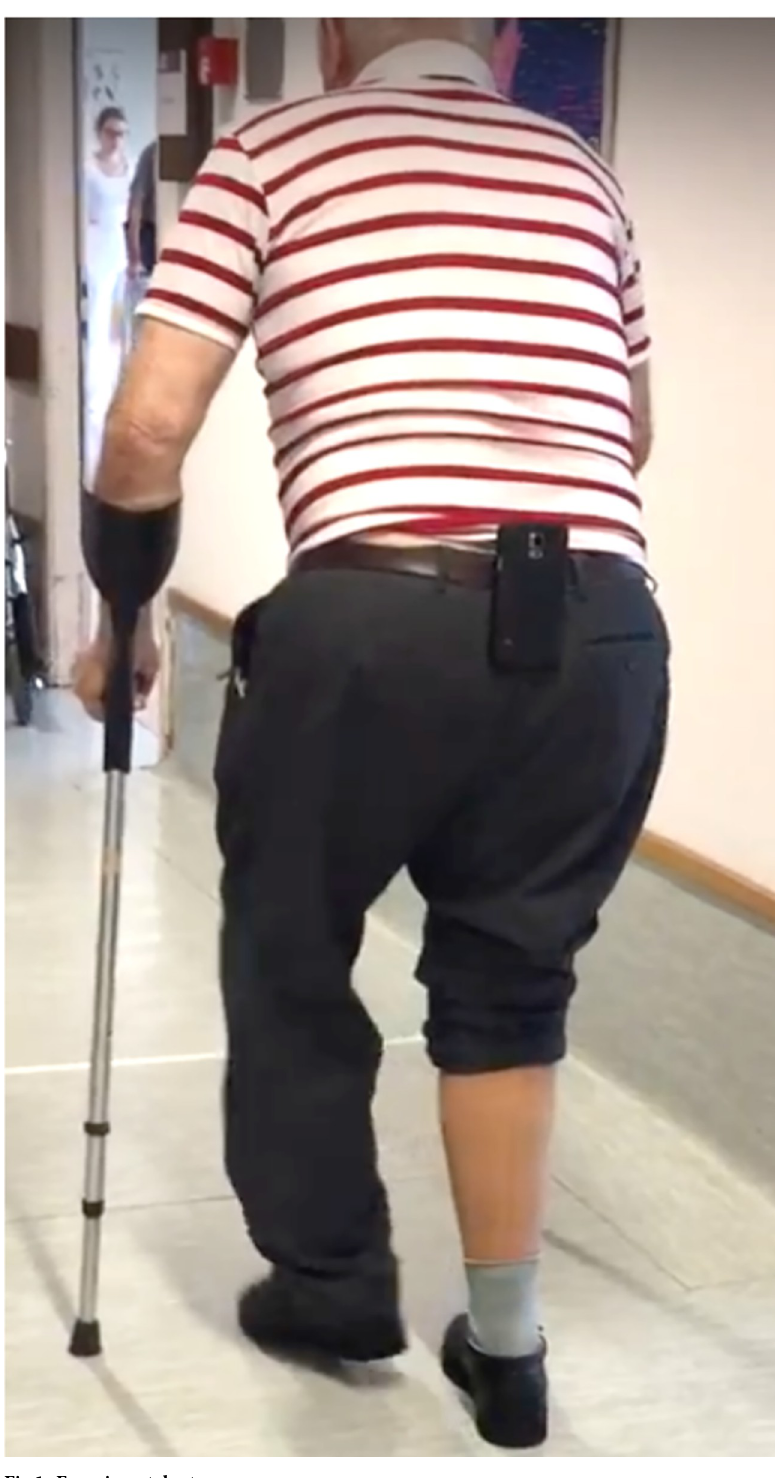
Fig 1. Experimental set-up.